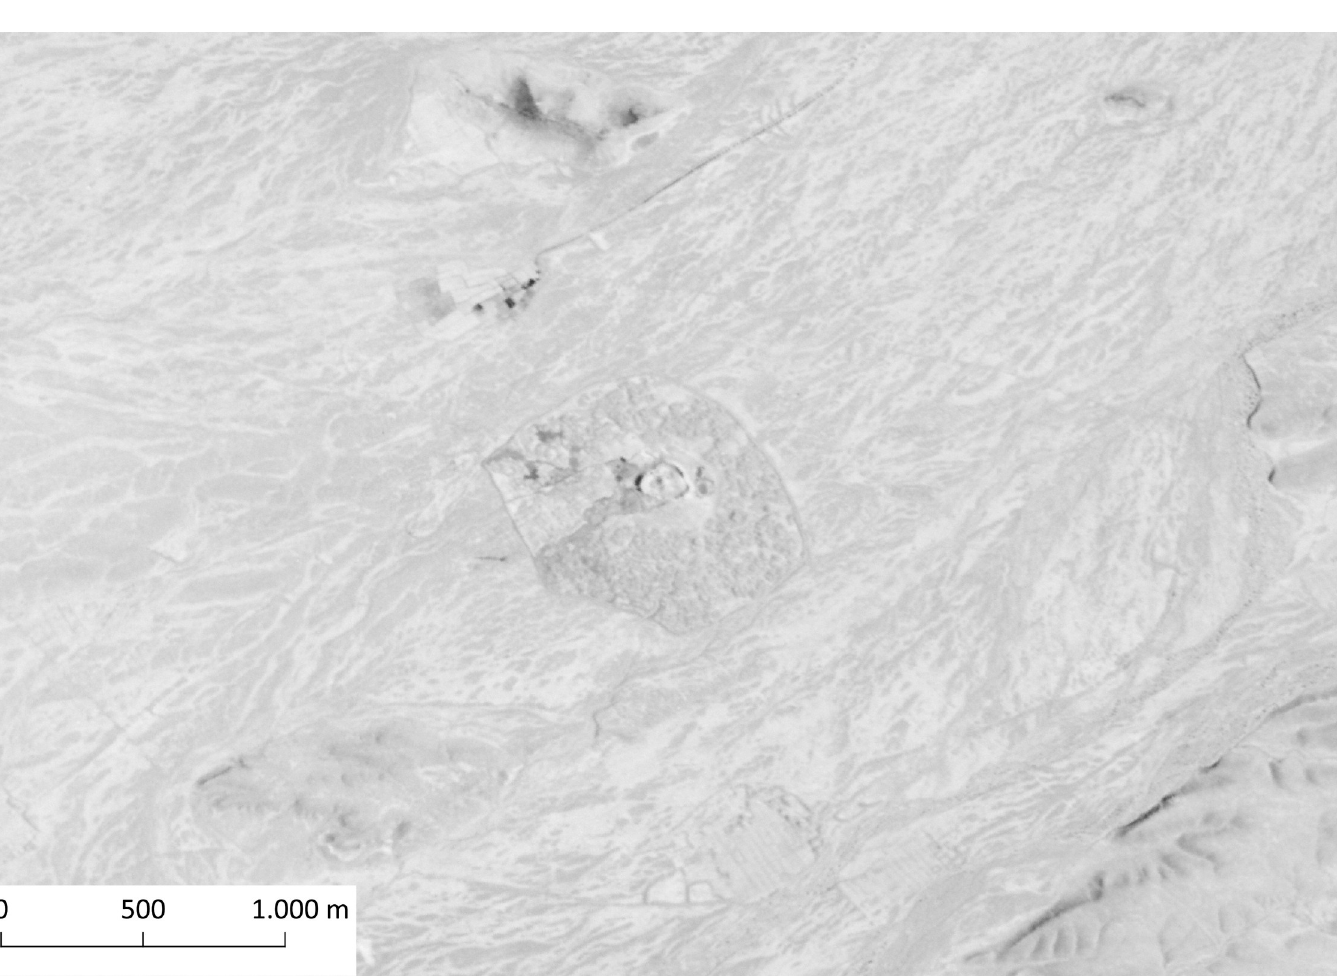
Fig 9. K311, the ruins of a fortified town with a citadel at its centre. CORONA Satellite image courtesy of the U.S. Geological Survey (DS1021-2119DF015_b, 05.26.1965)